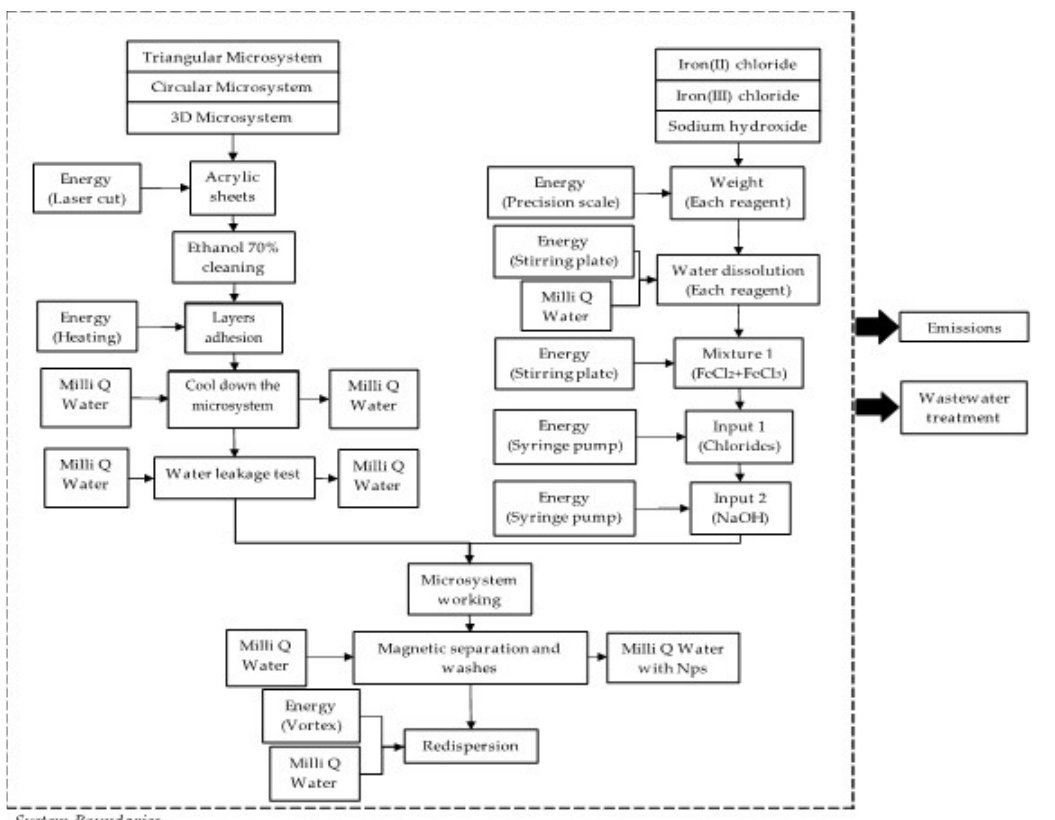
Figure 4. Flowchart diagram of the micromixer−based method for the synthesis of Fe 3 O 4 NPs. The system boundaries are defined by the dotted framework.